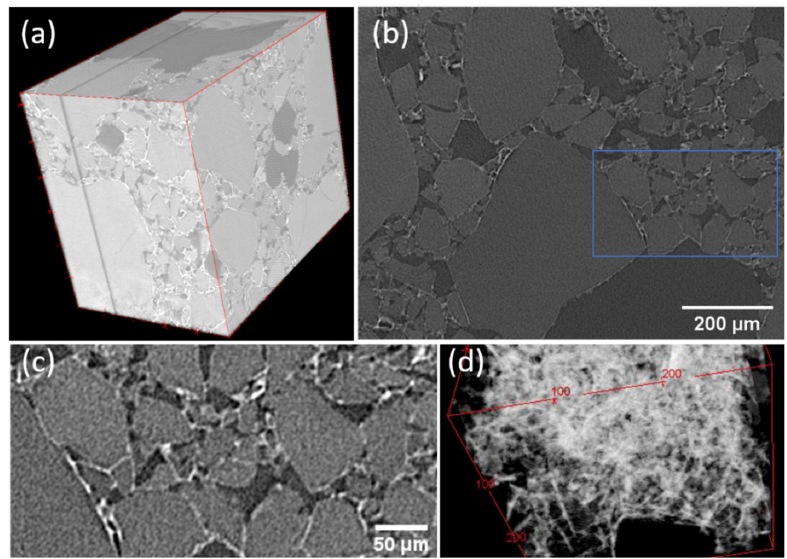
Figure A2. Composite aerogel with binder, and 3D-reconstructed ESRF X-ray tomogram to illustrate the post-treatments performed; ( a ) raw 3D volumes showing the three phases, (the binder, SAP, and IP); ( b ) cross-section resulting from ( a ) showing in white the binder has a discrete element in IP (outside SAP); ( c ) zoom in ( b ) (shown as a blue perimeter) showing that the organic binder either wraps SAP or connects SAP with fibrils; ( d ) after segmentation to separate the binder phase, (3D crop to show the connectivity of the binder phase).